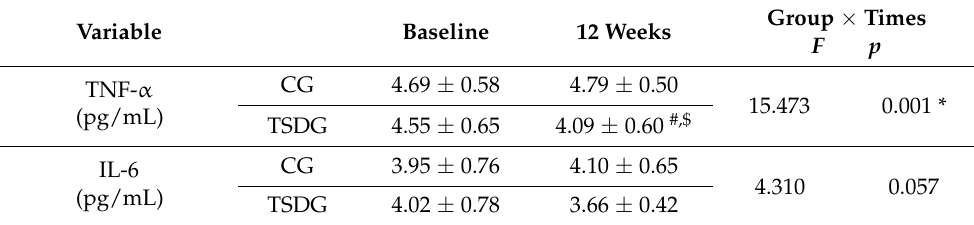
Table 7. Changes in inflammatory factors after the 12-week Taekwondo training